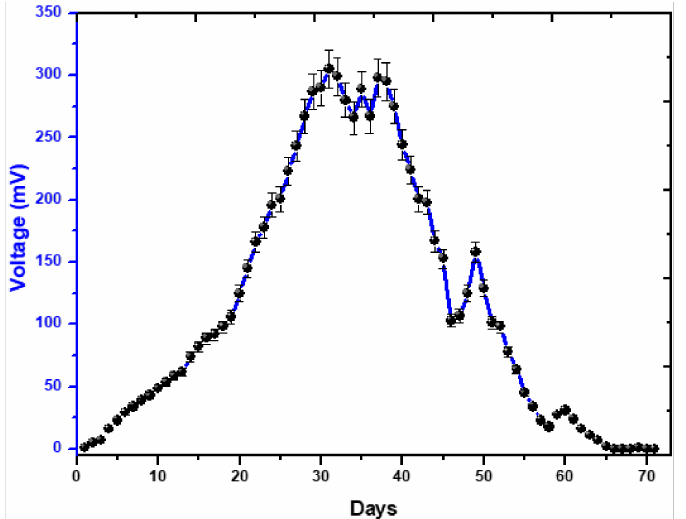
Figure 2. The voltage generation trend throughout the 70